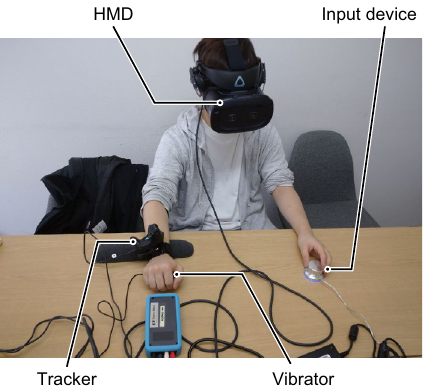
Figure 5. Experimental setup. The participants held the vibrator with their right hand and the control knob with their left hand. Hand movements were traced using the tracker on the right-hand wrist, which reposed on a rest